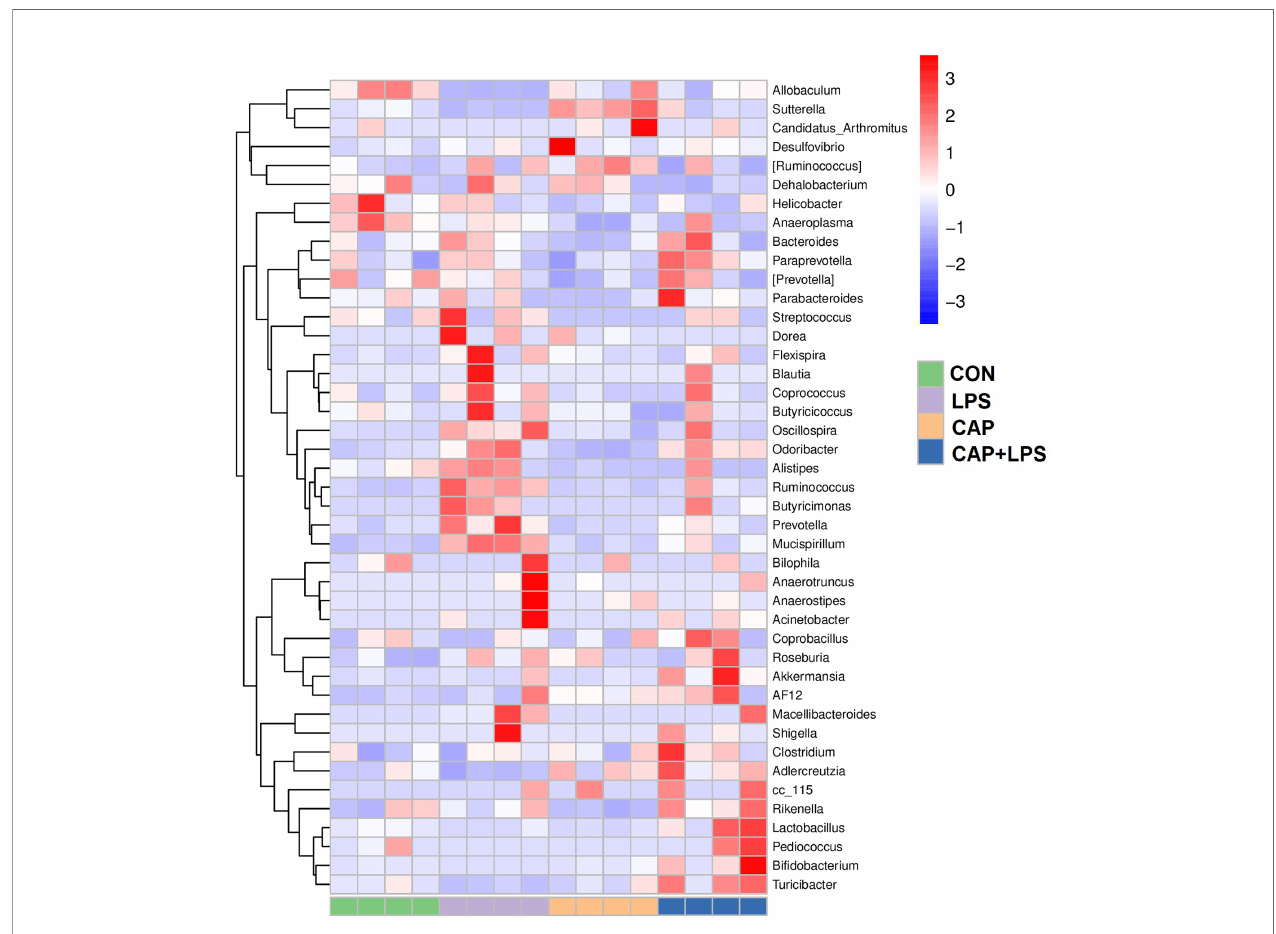
FIGURE 8 | The heat map of microbe relative abundance of the genus (n = 4). Colors indicate the values (high values in red, low in